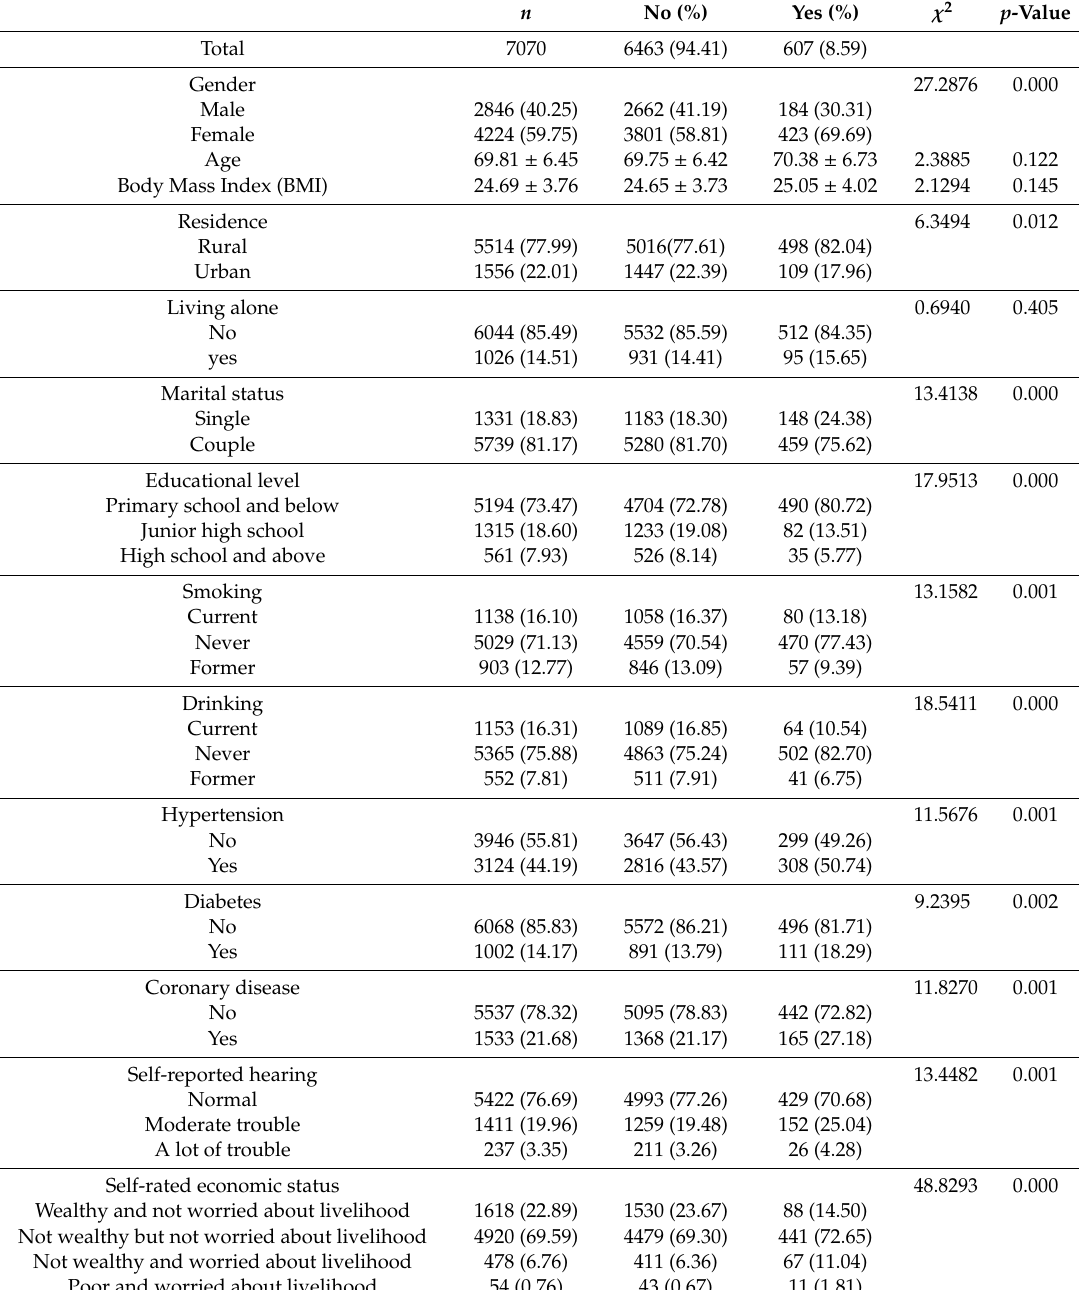
Table 1. Prevalence of falls in the past six months by participant characteristics among the elderly in Shandong, China ( n =